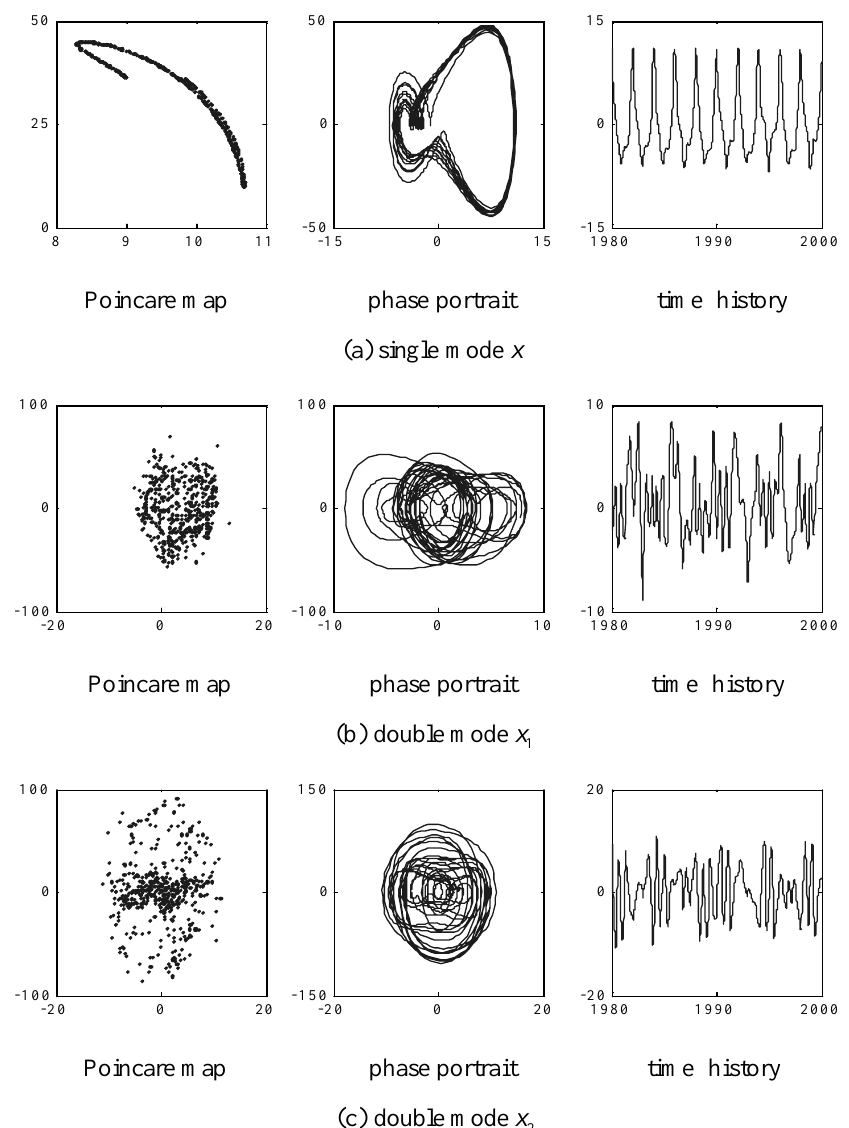
Fig. 6. Comparison between single and double mode models ( ω = π,g = 200